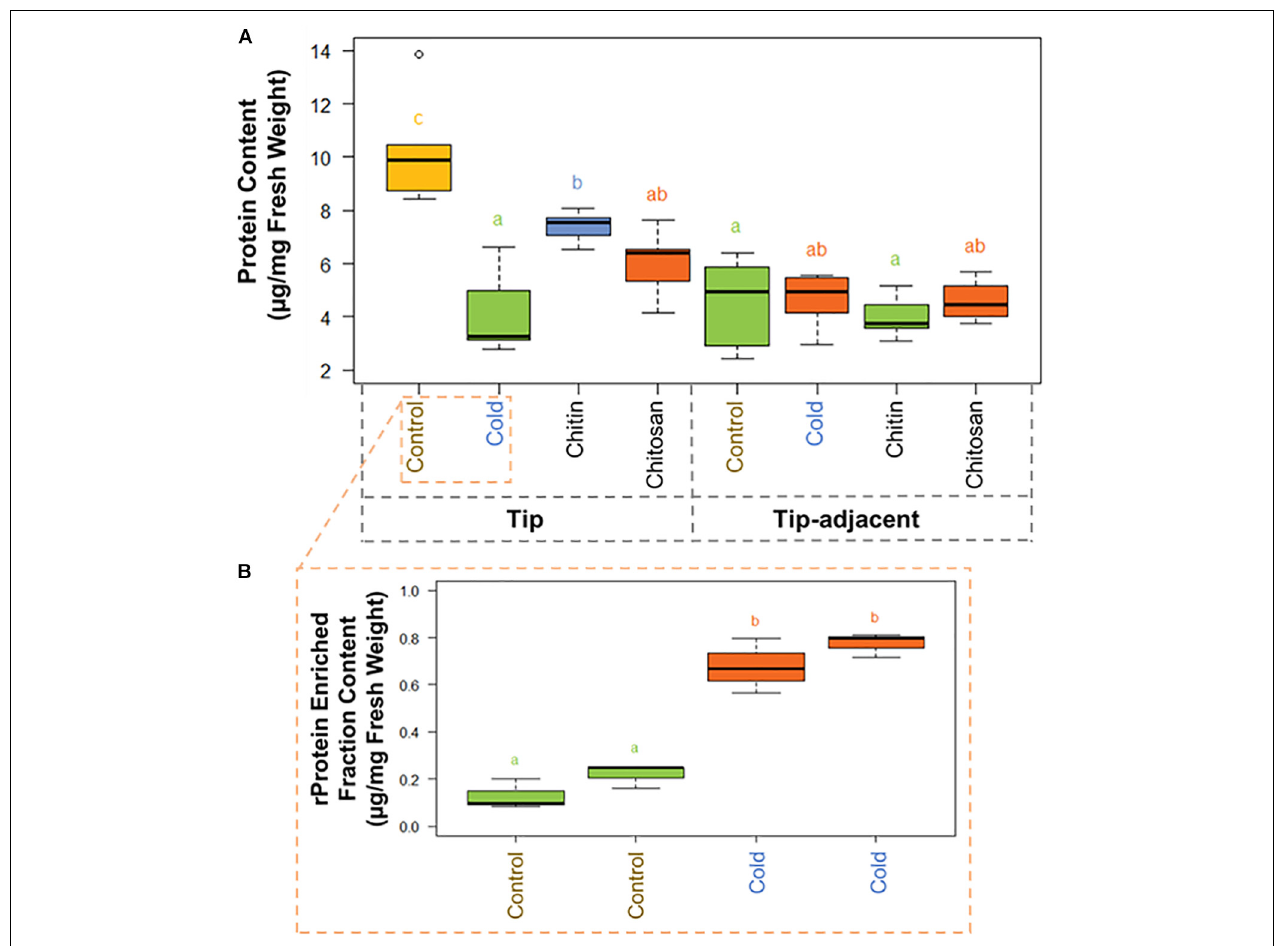
FIGURE 3 | Protein content boxplots from Hordeum vulgare roots treated during germination with cold temperature, or additions to the germination solution (chitin or chitosan). See also Supplementary Figure 5 and Supplementary Table 3 . (A) Total protein content was measured after protein extraction from 40 mg ± 5% of starting root material and overnight precipitation ( n = 5). (B) Ribosomal protein (rProtein) content was measured after ribosome enrichment from 200 mg ± 5% of starting root material using a sucrose cushion and ribosomal protein dissociation using GuHCl as chaotrope ( n = 3 × 2 experimental blocks). Protein contents were measured using the bicinchoninic acid (BCA) assay with starting tissue amounts that yielded protein concentrations in the linear range of the assay. The protein content values were calculated from a linear regression of bovine serum albumin (BSA) standards after blank correction [i.e., to 3 M of urea in 50 mM of triethylammonium bicarbonate (TEAB)]. Subsequently, we tested the data normality and homoscedasticity assumptions to assess the applicability of univariate statistical tests; we used the Shapiro–Wilk and the Brown–Forsythe Leven-type test based on the absolute deviations from the median, bootstrapped when n > 10. The tip and upper root zone datasets are normally distributed and homoscedastic; the full dataset is gamma distributed and homoscedastic ( Supplementary Figure 5 ). Generalized linear models (GLMs) of the Gaussian and gamma families were used to evaluate the difference between the means in the datasets and gave equivalent statistical differences as an ANOVA comparison followed by Tukey honestly significant difference (HSD) test between means. Therefore, small letters and color progressions derived from the Tukey HSD test are used to denote statistically different means.